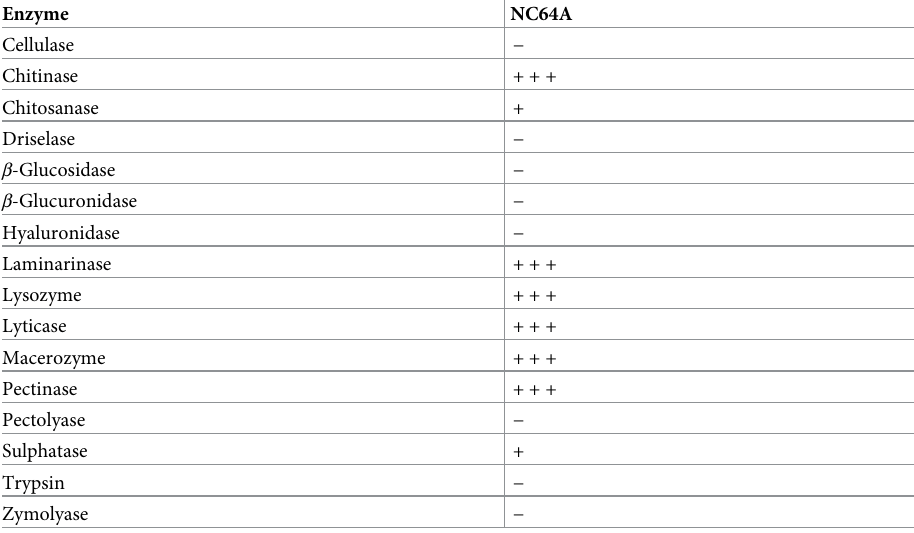
+++, complete growth inhibition; ++ moderate growth inhibition; +, slight growth inhibition; − , no growth